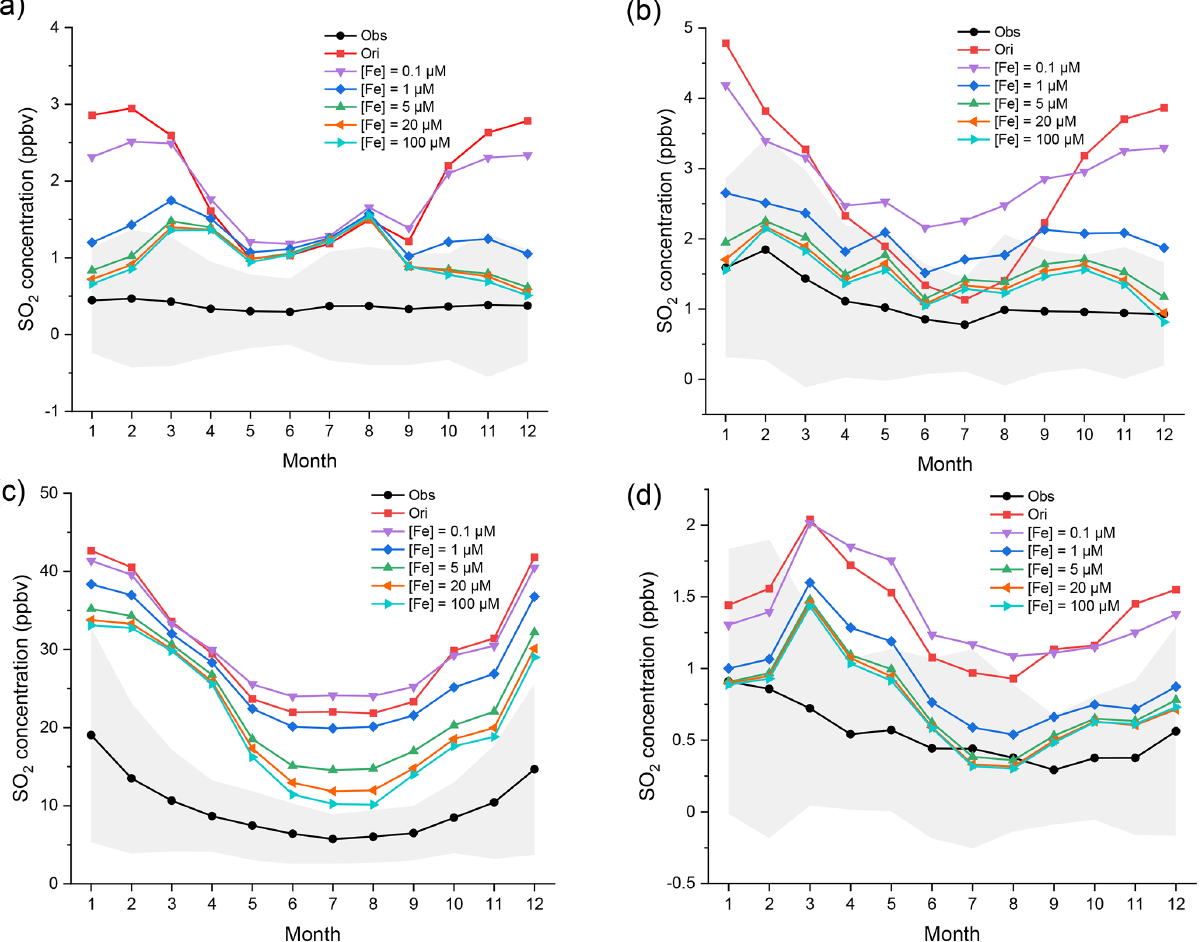
Figure 6. Regional monthly average mixing ratios (ppbv) of SO 2 in EU, USA, CN, and JK in 2015. The black and red lines represent the observed and original-simulated mixing ratios of SO 2 , respectively. Other lines represent SO 2 mixing ratios with different soluble [Fe 3 + ]. [Fe 3 + ], from top to bottom, is 0.1, 1, and 5 (i.e., the improved case) and 20 and 100µM, respectively. The gray areas represent the standard deviation of observed mixing ratios. The corresponding monitoring networks are (a) EMEP, (b) EPA, (c) CNEMC, and (d)